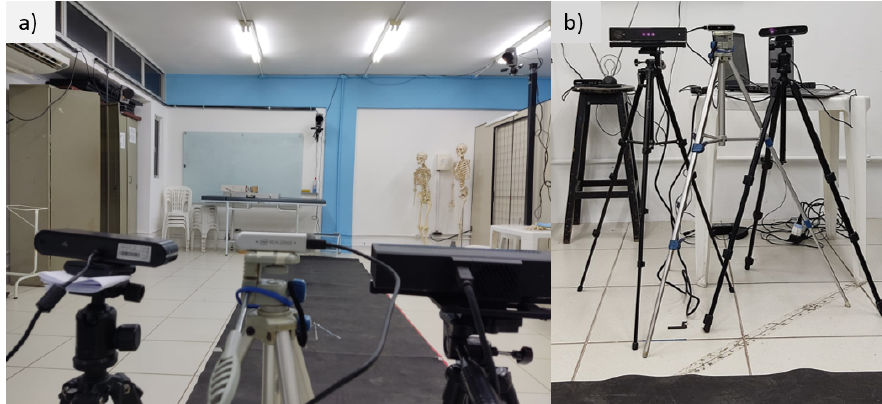
Figure 2. View of the RGB-D equipment. ( a ) Posterior view of the equipment aligned with the recording track. ( b ) Front view of the equipment and lifting